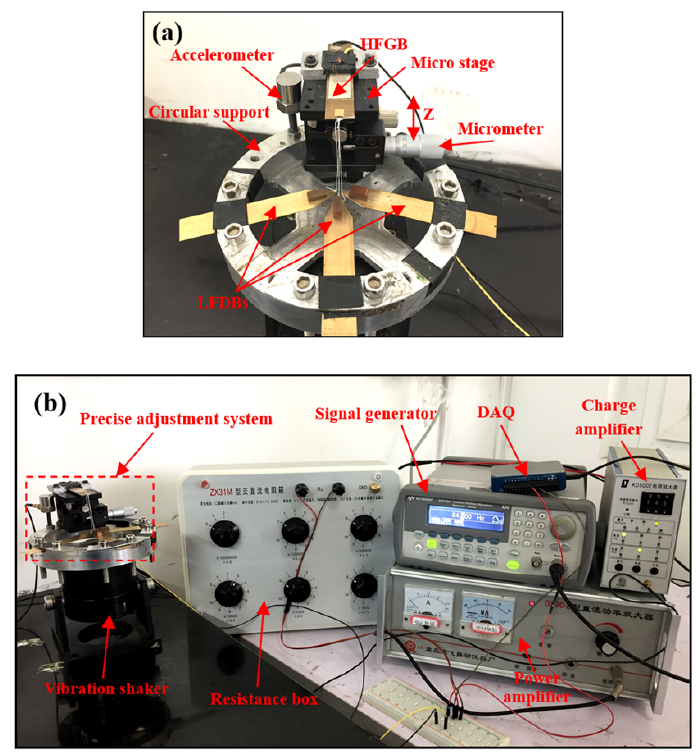
Figure 5. Experimental setup of the novel piezoelectric vibration energy harvester (PVEH) system. ( a ) Precise adjustment system; ( b ) vibration testing setup.